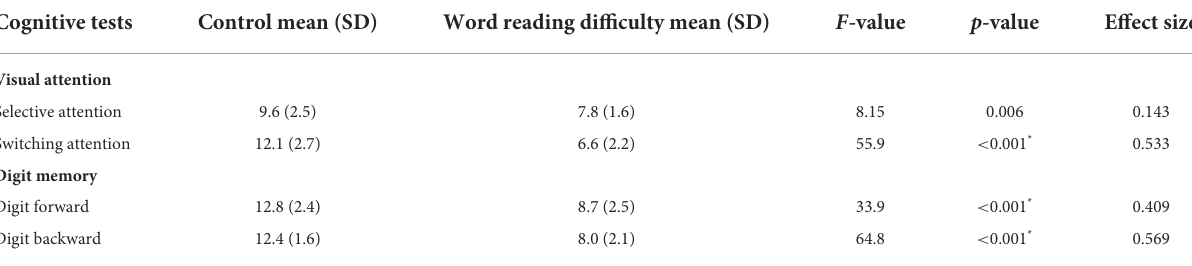
TABLE 4 Univariate ANOVA results alongside the means (and standard deviations in parentheses) across the two groups for the visual attention and working memory tests. Cognitive tests Control mean (SD) Word reading difficulty mean (SD) p -value Effect